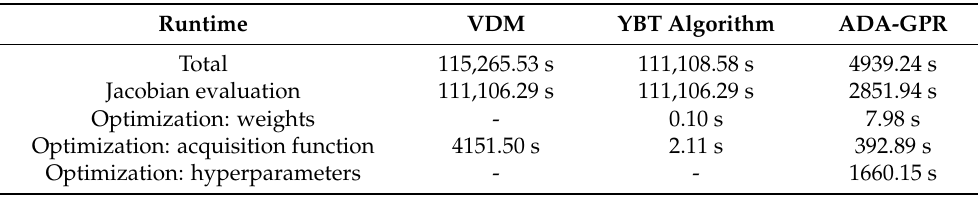
Table 15. Detailed breakdown of the runtime of all algorithms for the yeast